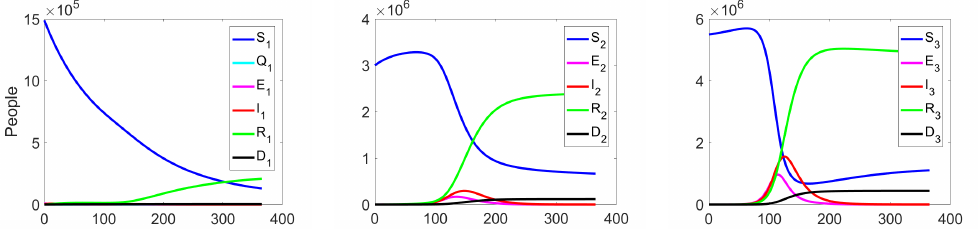
Figure 7. Experiment 1. Spread of the virus in three different clusters in a controlled case.